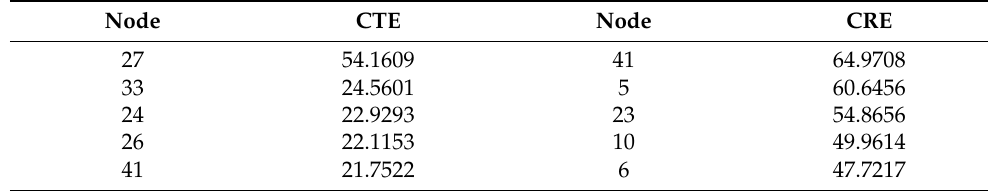
Figure 12. k-means clustering results (the gray dots are the centroids of each category identified by the clustering algorithm). Table 3. Top 5 nodes in CRE and